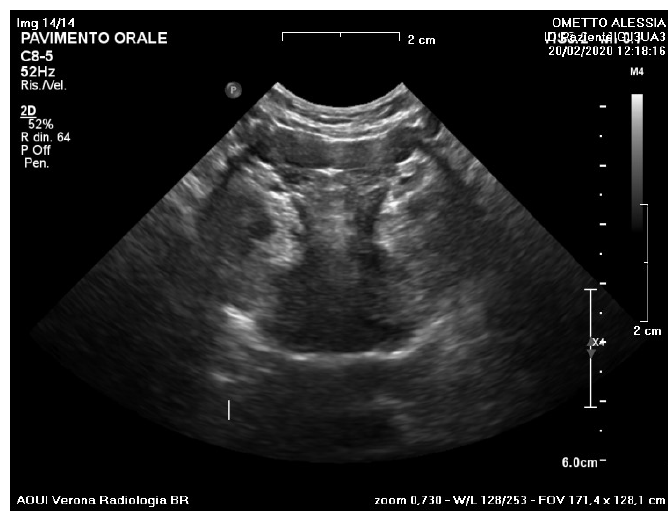
Figure 7. Ultrasound re ‐ evaluation at 10 months showed complete resolution of the lesion.